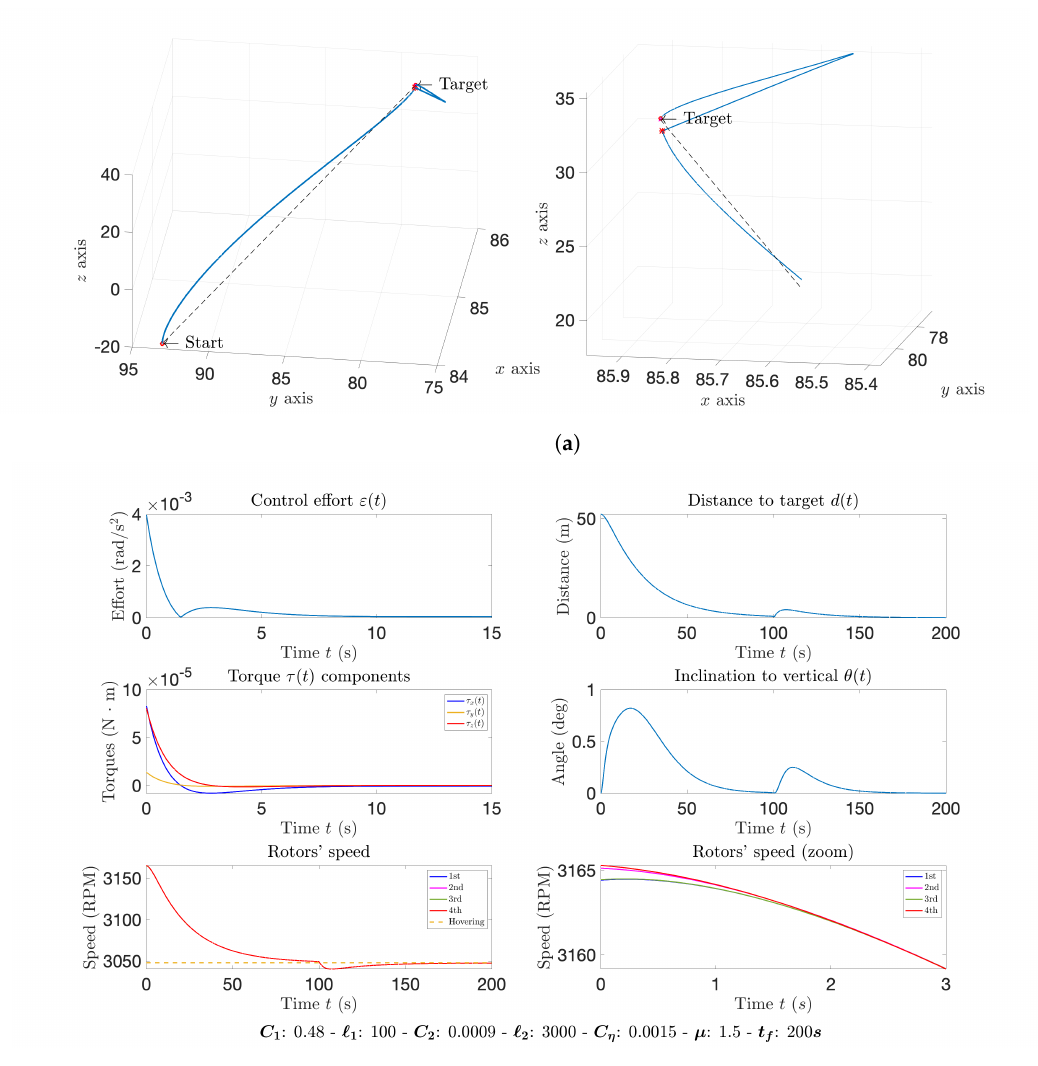
Figure 12. Experiment: Single impulsive force acting after the drone has reached the target. The hit point on the target-approaching panel is marked by a red asterisk. ( a ) Target approaching trajectory; ( b ) Control